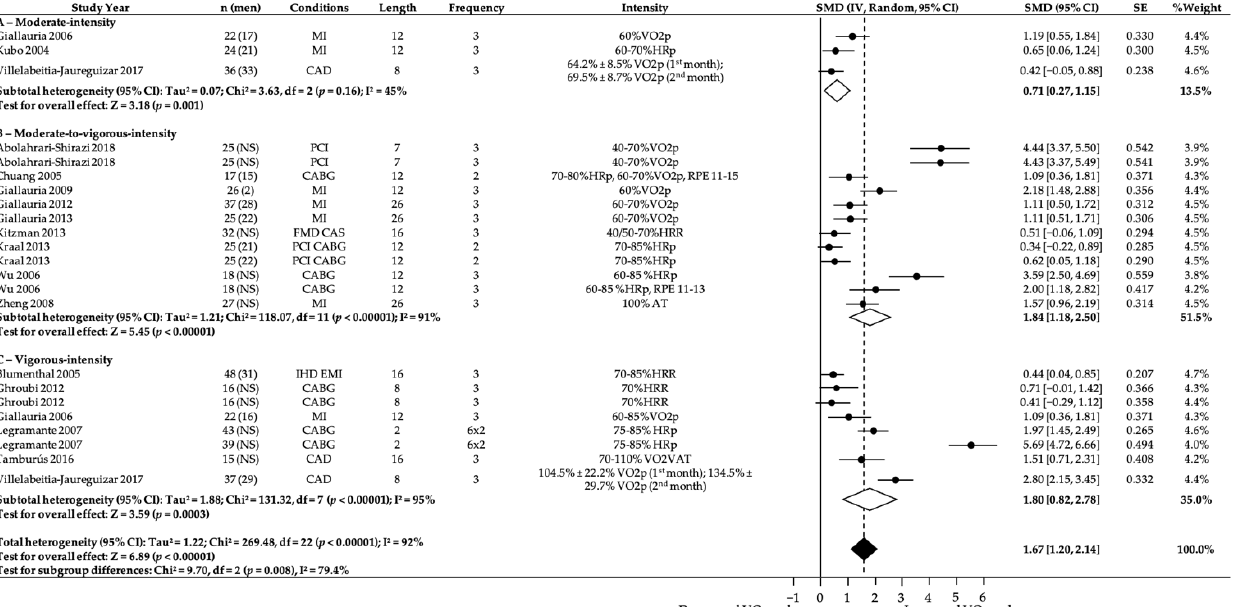
Figure 3. Effect of moderate-, moderate-to-vigorous- and vigorous-intensity exercise during exercise programs on change in relative VO 2 peak (mL-kg −1 -min −1 ). NS, not stated/missing. HRR, heart rate reserve. HRp, heat rate peak. RPE, rate of perceived exertion. AT, anaerobic threshold. VAT, ventilatory anaerobic threshold. 95% CI, 95% confidence interval. SMD, standardized mean difference. IV, Random: a random-effects meta-analysis was applied, with weights based on inverse variances. SE, standard error. Tau 2 and I 2 , heterogeneity statistics. df, degree of freedom. Chi 2 , the chi-squared test value. Z, Z-value for test of the overall effect. P, p-value. Conditions: MI, myocardial infarction. CABG, coronary artery bypass graft. PCI, percutaneous coronary intervention. CAD, coronary artery disease. IHD, ischsemic heart disease. EMI, exercise-induced myocardial ischemia. FMD, endothelial-dependent flow-mediated arterial dilation. CAS, carotid artery stiffness.